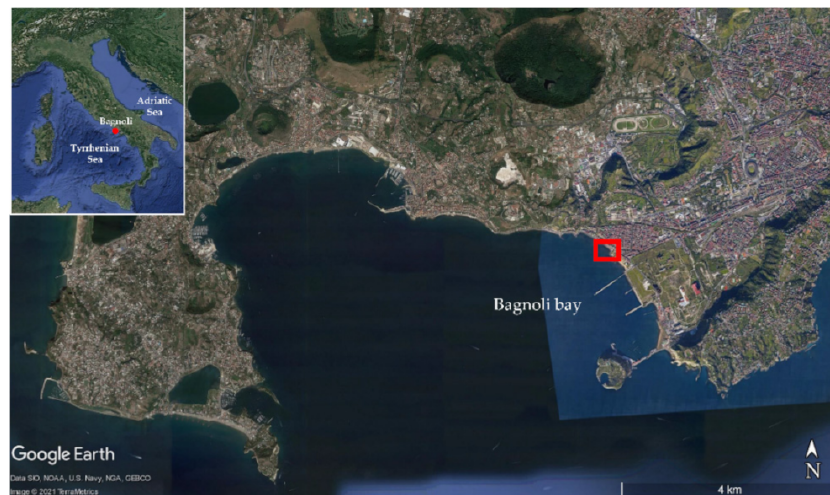
Figure 12. Location of the Bagnoli bay case of study.